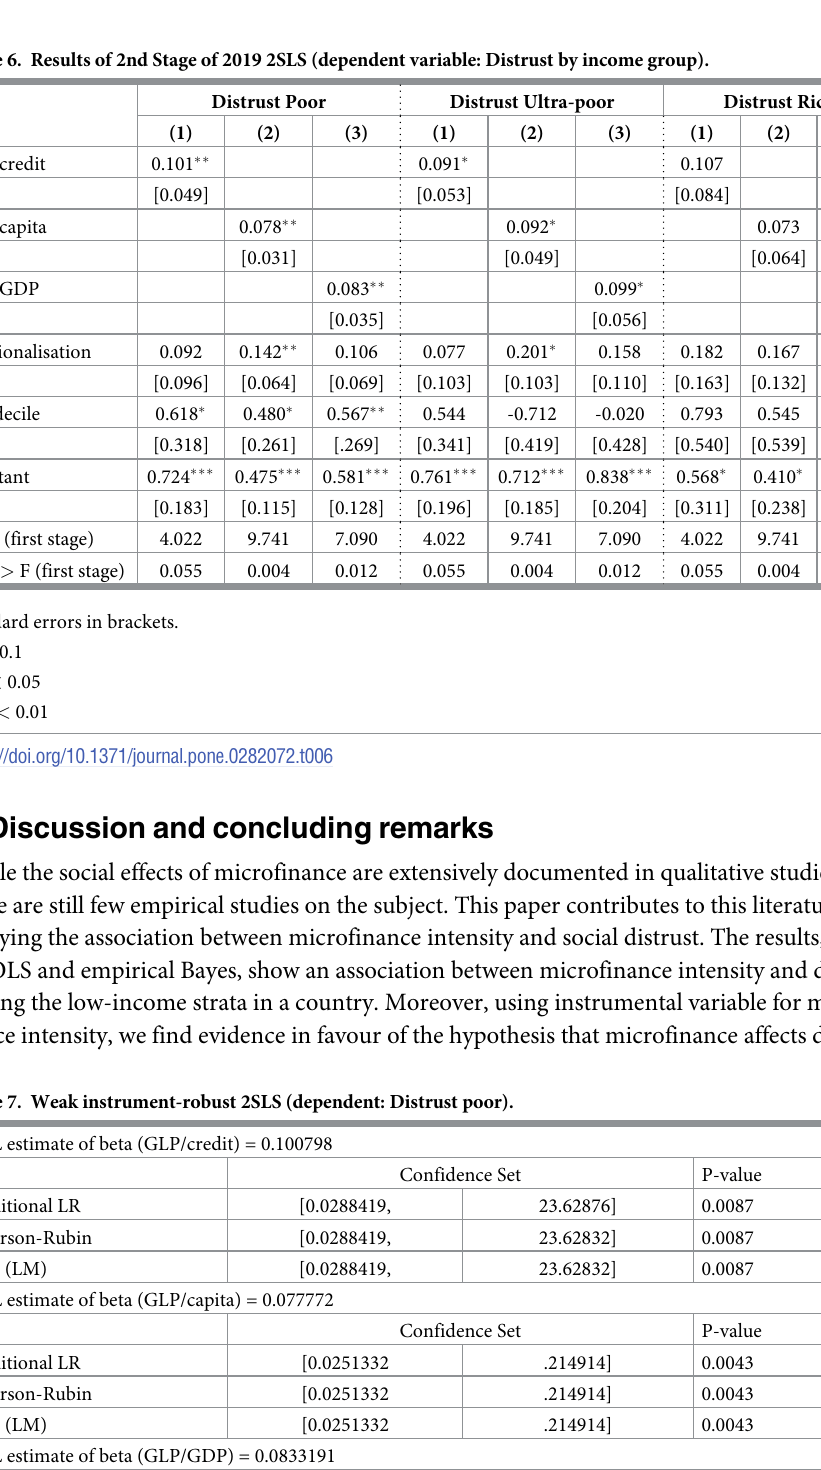
Table 6. Results of 2nd Stage of 2019 2SLS (dependent variable: Distrust by income group). Distrust Poor Distrust Ultra-poor